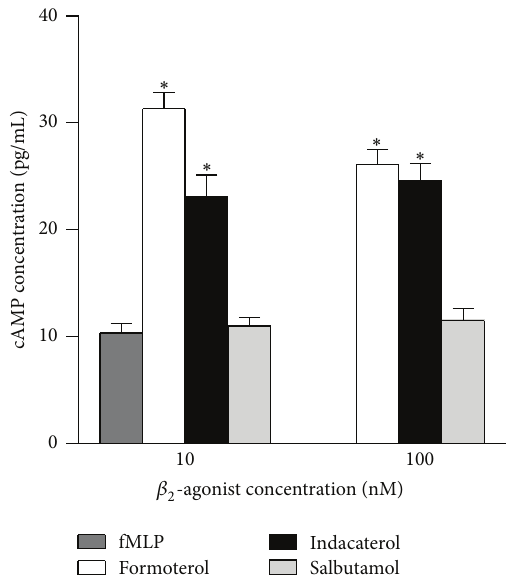
Figure 5: Effects of formoterol, indacaterol, and salbutamol (10 and 100nM) on cAMP levels in neutrophils. The results of 5 separate experiments ( 𝑛 = 5 ) with 2 replicates for each drug concentration and control system in each experiment are expressed as the mean ± SEM. The absolute value for the control system was 10.4 ± 0.9 pg mL −1 . ∗ 𝑃 < 0.001 for comparison with the drug-free control systems.